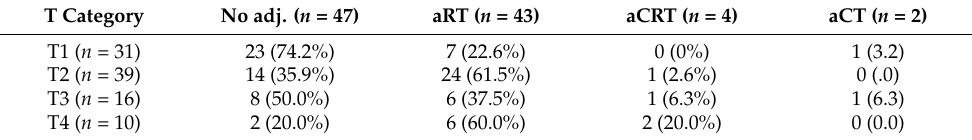
Table 4. Adjuvant treatment after TLM over T category. No adj. = No adjuvant therapy.